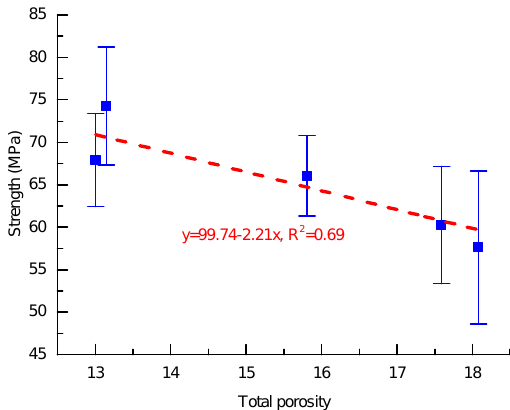
Figure 4. Relationships between strength and